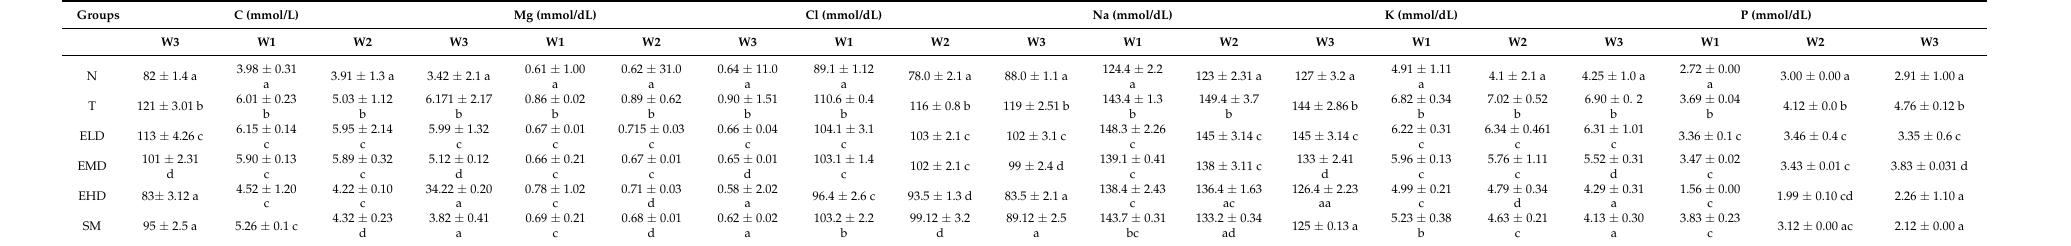
Table 5. The effects of (DO.AQ) extracts on serum albumen, glucose and serum electrolytes of various experimental